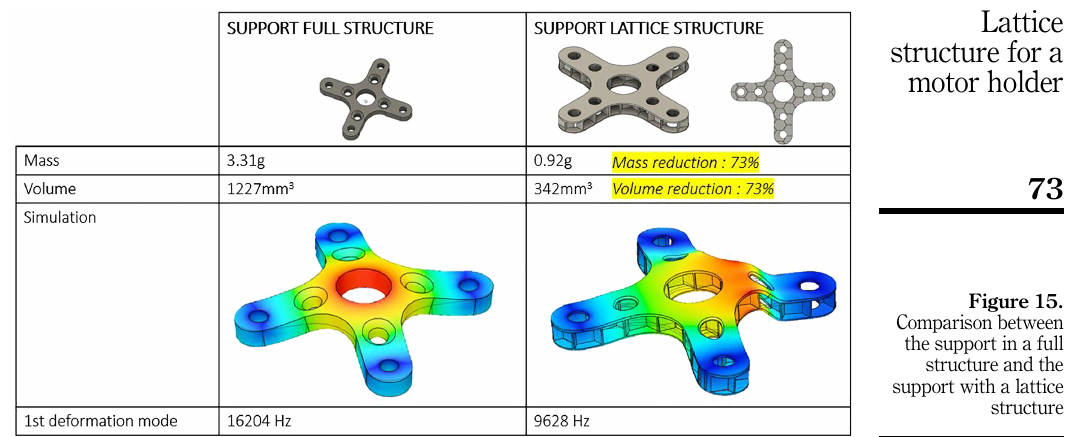
Figure 15. Comparison